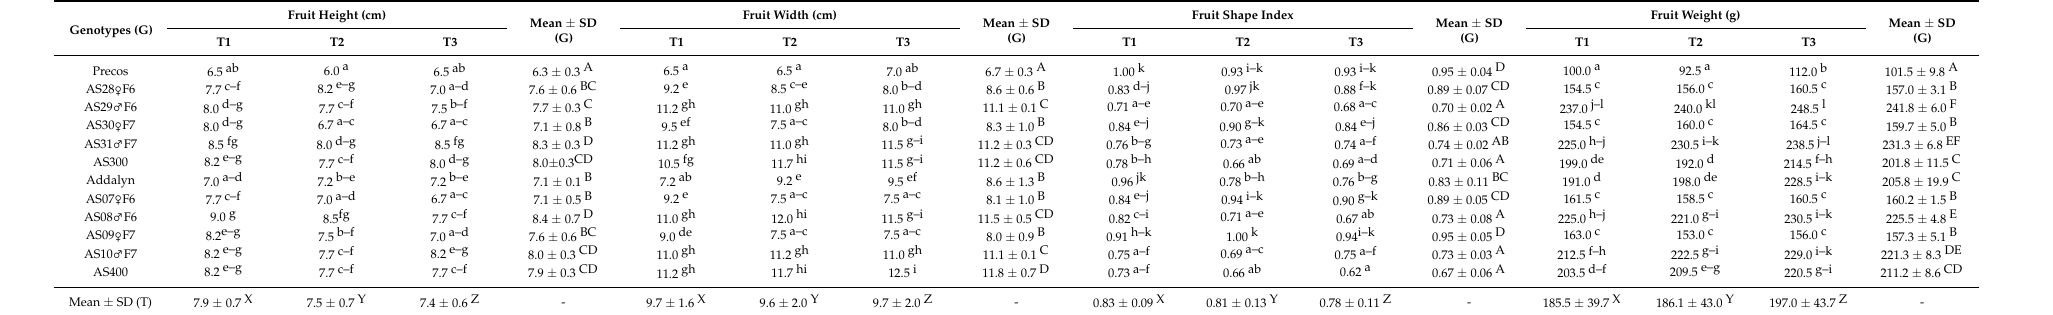
Table 5. The main characteristics of fruits according to genotype and treatment.